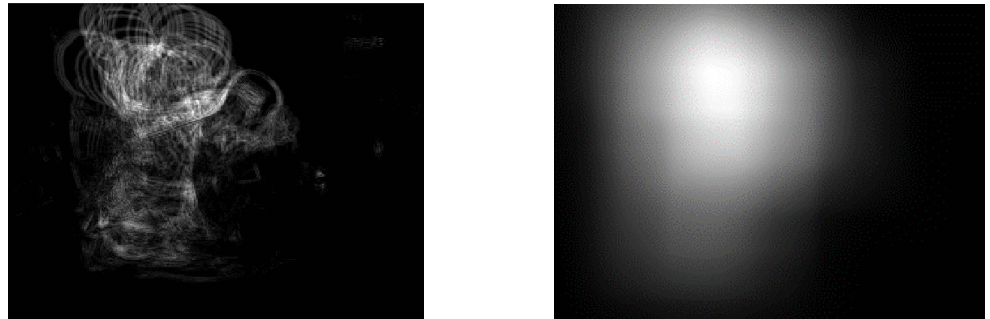
Figure 4. ( Left ): video energy map; ( right ): the resulting image after applying the average filter.